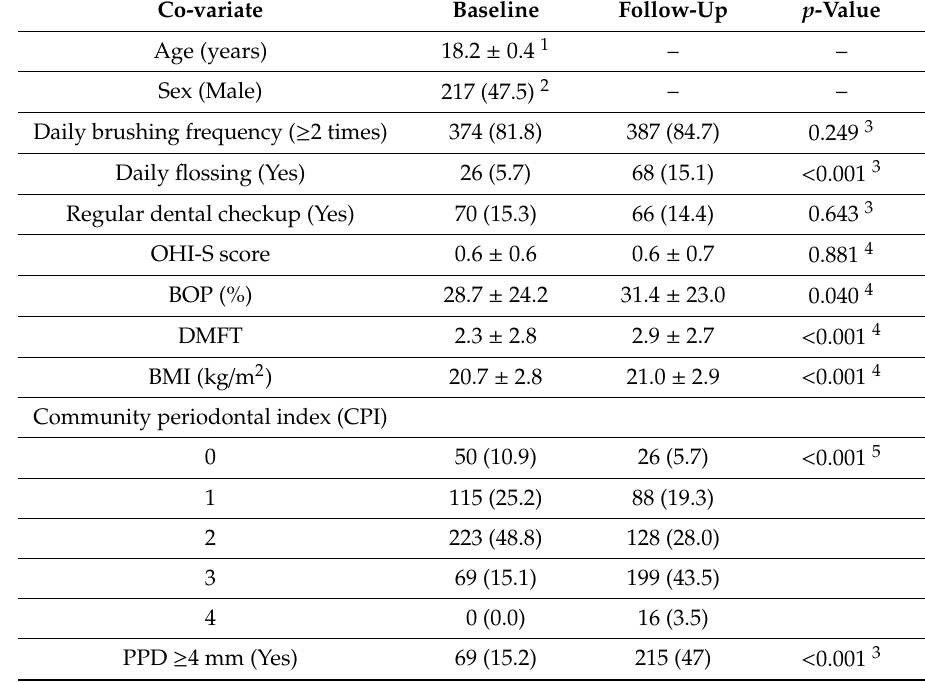
Table 1. Demographics and change in parameters from baseline to follow-up among all students ( n = 457). Co-variate Baseline Follow-Up p -Value Age (years) 18.2 ± 0.4 1 – – Sex (Male) 217 (47.5) 2 – – Daily brushing frequency ( ≥ 2 times) 374 (81.8) 387 (84.7) 0.249 3 Daily flossing (Yes) 26 (5.7) 68 (15.1) < 0.001 3 Regular dental checkup (Yes) 70 (15.3) 66 (14.4) 0.643 3 OHI-S score 0.6 ± 0.6 0.6 ± 0.7 0.881 4 BOP (%) 28.7 ± 24.2 31.4 ± 23.0 0.040 4 DMFT 2.3 ± 2.8 2.9 ± 2.7 < 0.001 4 BMI (kg / m 2 ) 20.7 ± 2.8 21.0 ± 2.9 < 0.001 4 Community periodontal index (CPI) 0 50 (10.9) 26 (5.7) < 0.001 5 1 115 (25.2) 88 (19.3) 2 223 (48.8) 128 (28.0) 3 69 (15.1) 199 (43.5) 4 0 (0.0) 16 (3.5) PPD ≥ 4 mm (Yes) 69 (15.2) 215 (47) < 0.001